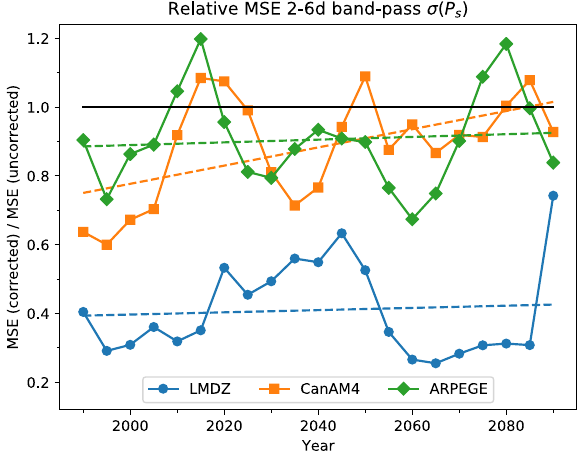
Fig. 4 Synoptic variability. Global average mean square error (MSE) of the corrected AGCM runs relative to the uncorrected reference runs for 20- year running averages of the temporal standard deviation of band-pass (2 – 6 days) fi ltered daily sea-level pressure (full lines). Values are calculated every 5 years. Dashed lines indicate the linear regression over the full period. The black constant line at y = 1, indicating the limit above which the bene fi t of the bias correction vanishes, is provided for visual